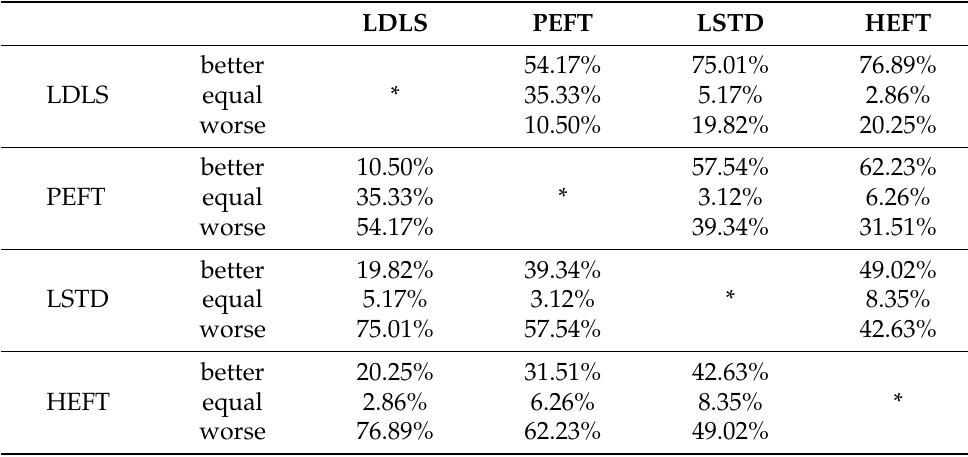
Table 1. Pairwise overall makespan comparison of the scheduling